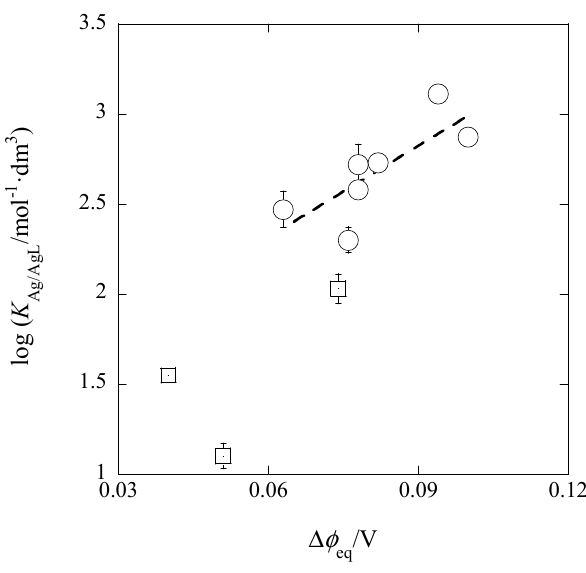
Figure 10. A plot of log K Ag/AgL vs. Δ φ eq for the AgPic extraction with B18C6 (= L) into DCE. See the text for the regression line (broken line).